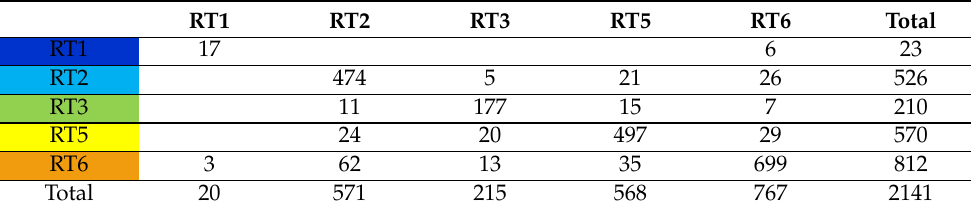
Table 6. The relationship between the predicted rock types (x) and the reference rock type from the core